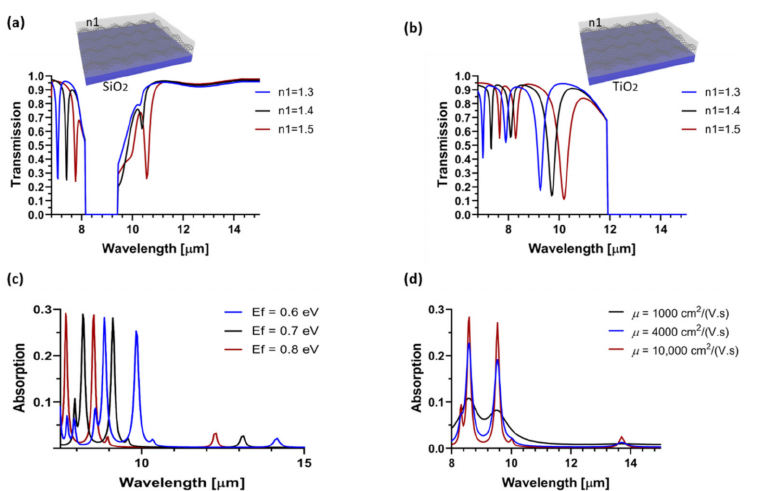
Figure 5. Substrate effect for plasmonic resonance shifts of biaxially crumpled graphene structures supported on ( a ) SiO 2 , and ( b ) TiO 2 , when the RI of solution atop the graphene n 1 changes from 1.3